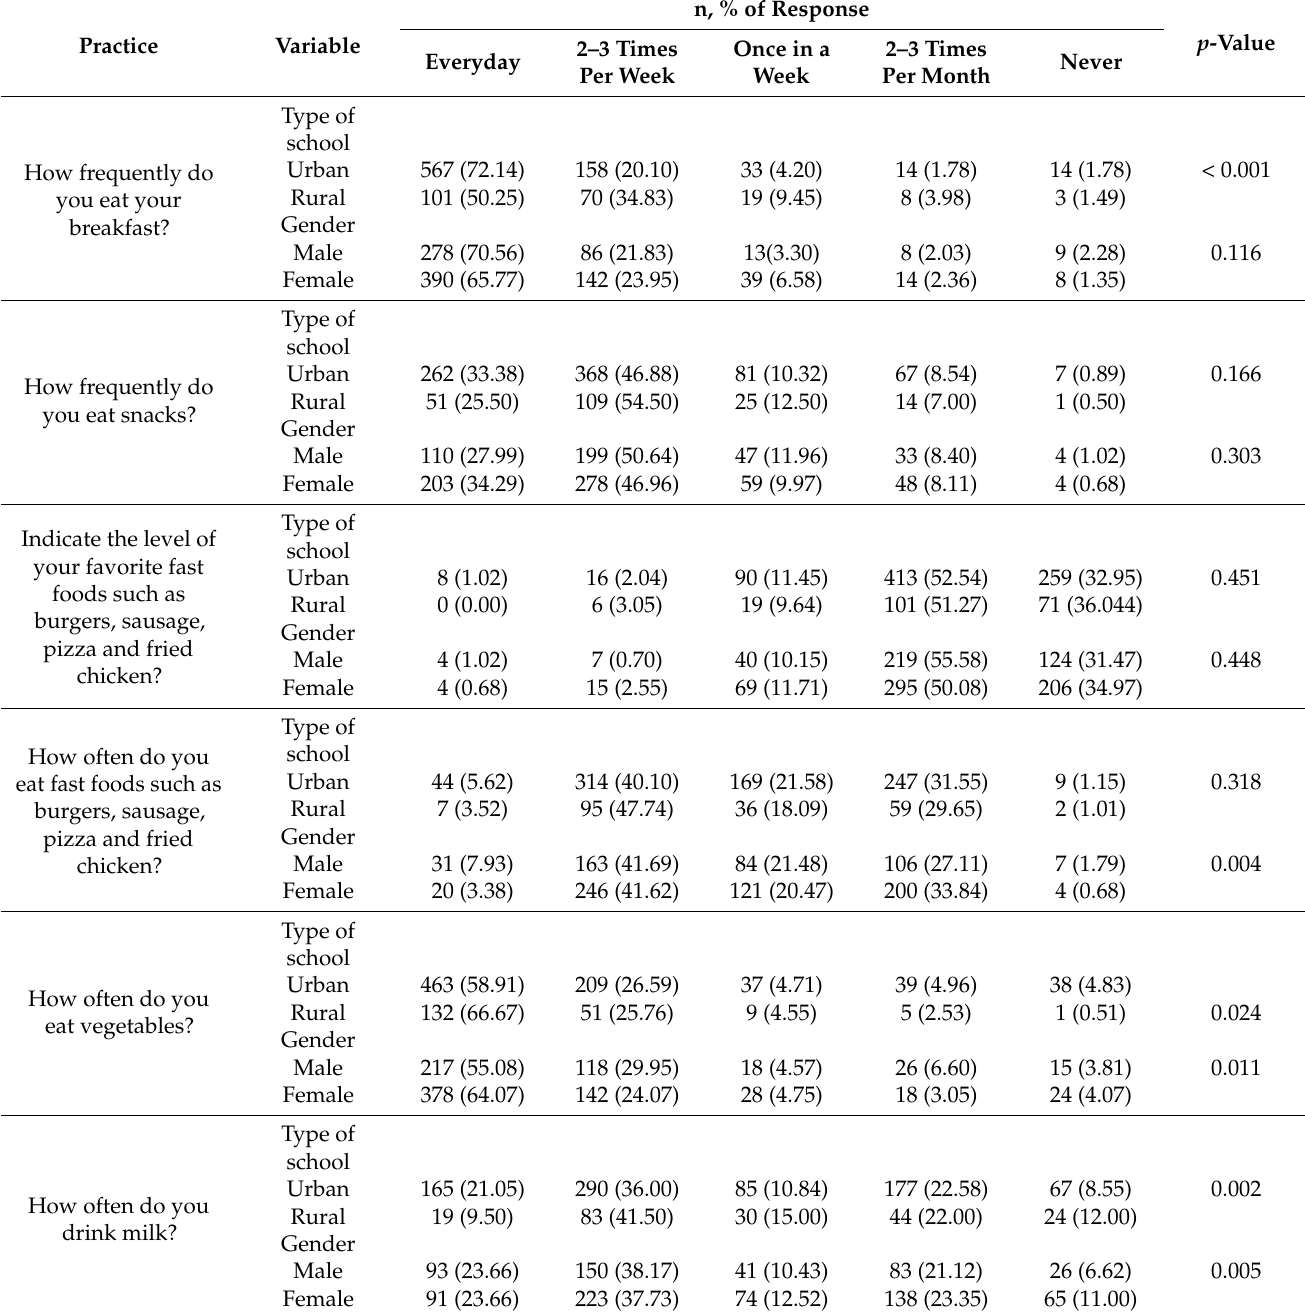
Table 4. Nutritional practices and their association with locality of schools and